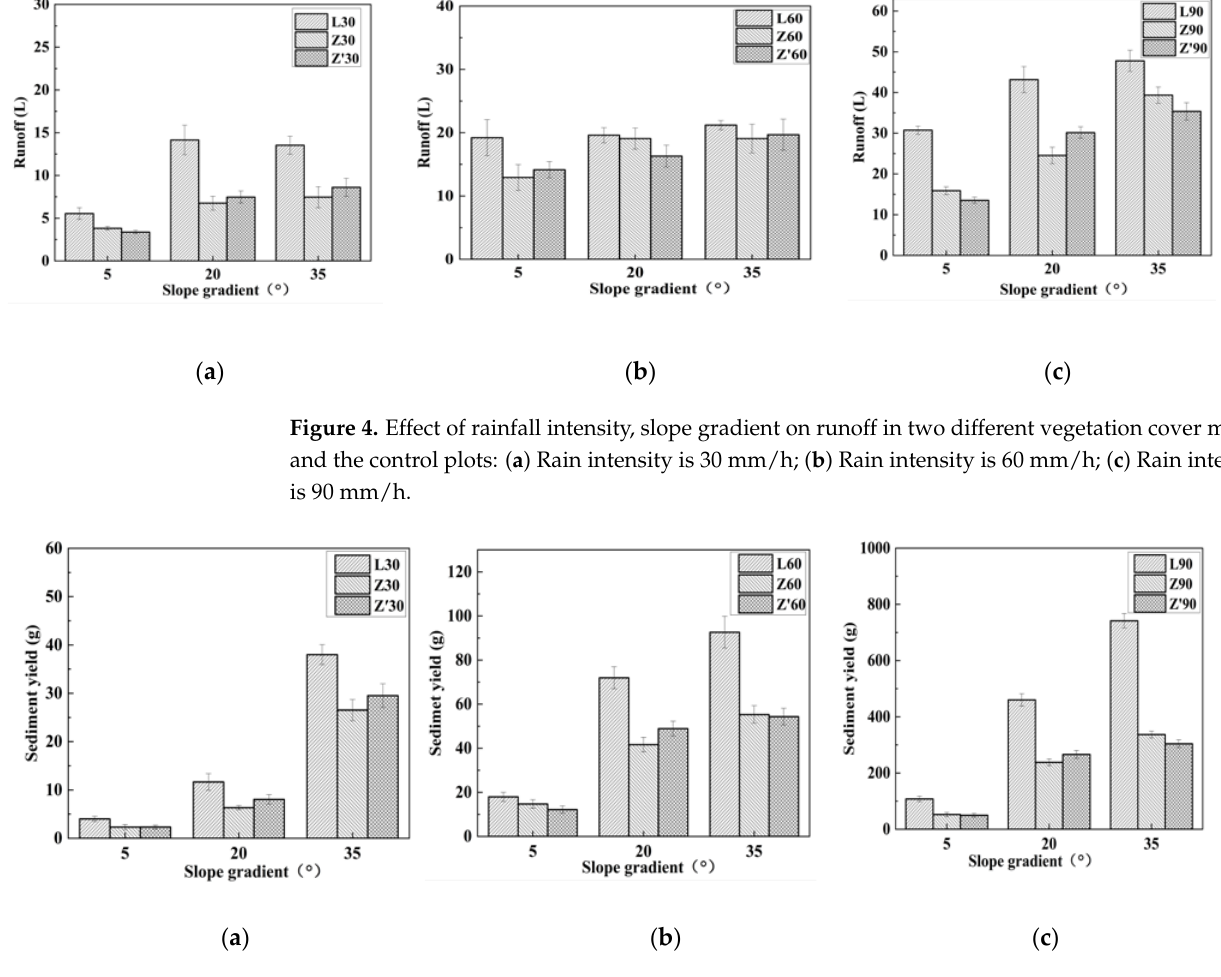
Figure 5. Effect of rainfall intensity, slope gradient on sediment yield in two different vegetation cover modes and the control plots: ( a ) Rain intensity is 30 mm/h. ( b ) Rain intensity is 60 mm/h. ( c ) Rain intensity is 90